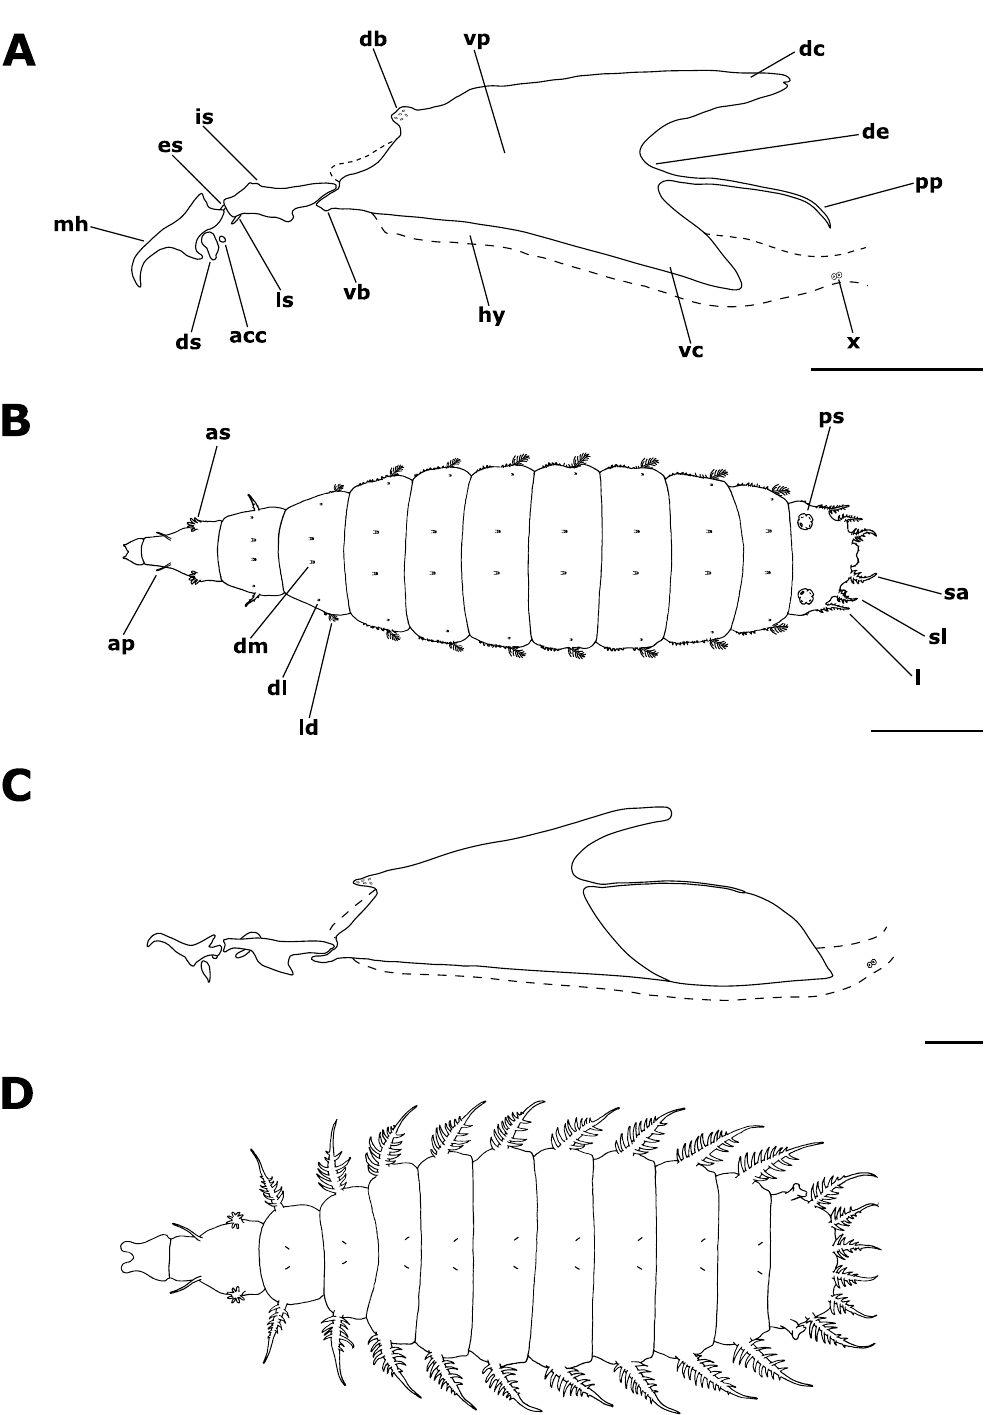
Figure 2. Third instar larvae of Fannia : ( A ) cephaloskeleton, Fannia nigra ; ( B ) larva in dorsal view, Fannia nigra ; ( C ) cephaloskeleton, Fannia pallitibia ; ( D ) larva in dorsal view, Fannia pallitibia . Scale bare 100 µm ( A , C ) and 1 mm ( B , D ). Abbreviations: acc, accessory stomal sclerite; ap, anterior process; as, anterior spiracle; db, dorsal bridge; dc, dorsal cornu, de, dorsal extension; dl, dorsolateral process; dm, dorsomedian process; ds, dental sclerite; es, epistomal sclerite; hy, hypopharynx; is, intermediate sclerite; l, lateral process; ld, laterodorsal process; ls, labial sclerite; mh, mouthhook; pp, posterior projection; ps, posterior spiracle; sa, subapical process; sl, sublateral process; vb, ventral bridge; vc, ventral cornu; vp, vertical plate; x, sensory organ X.